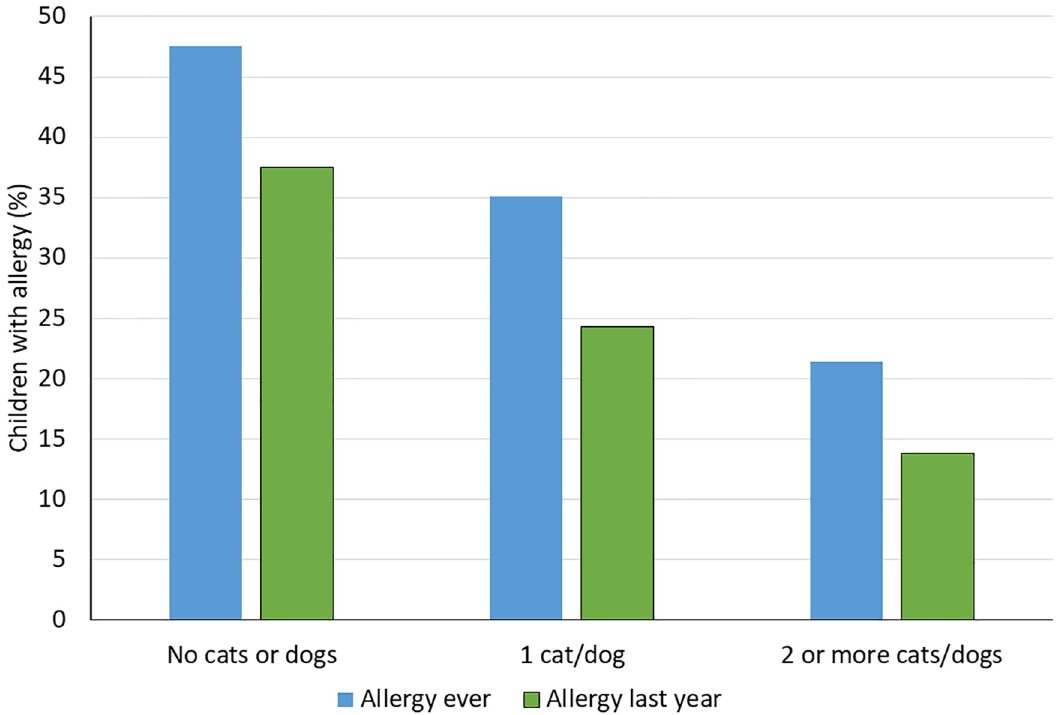
Fig 2. Data from the Birth Cohort. Allergy (any of asthma, allergic rhinoconjunctivitis, or eczema) in relation to the number of household cats and dogs when the child was 6 months old. Allergy last year required current symptoms, i.e. symptoms in the last 12 months.